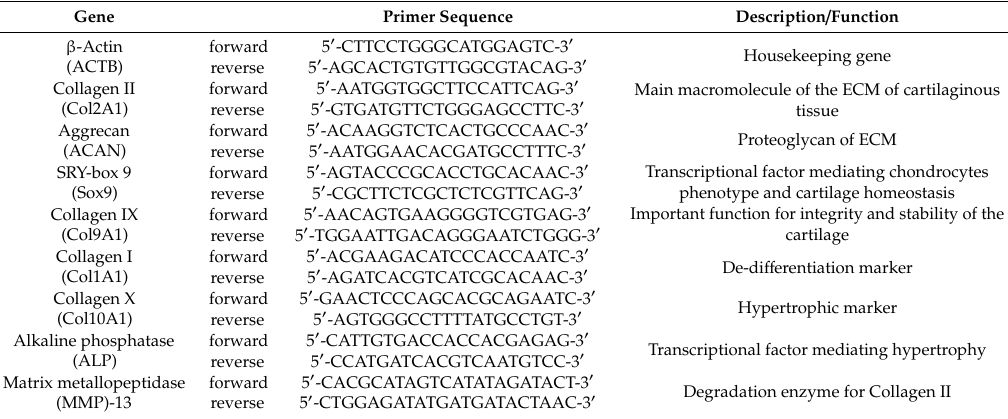
Table 1. Overview of used primers for